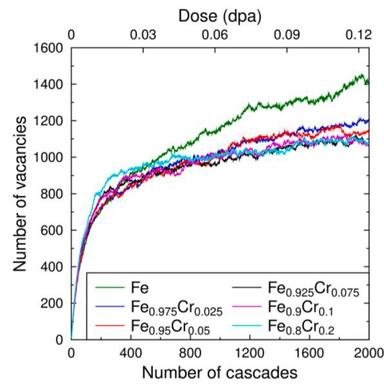
Number of vacancies as a function of dose/the number of cascade events in a simulation cell, simulated using sequential generation of collision cascades in FeCr alloys containing different amounts of Cr. Simulations were performed using cells containing ~500,000 atoms. 1000 vacancies correspond to the asymptotic high-dose vacancy content of approximately 0.2%.